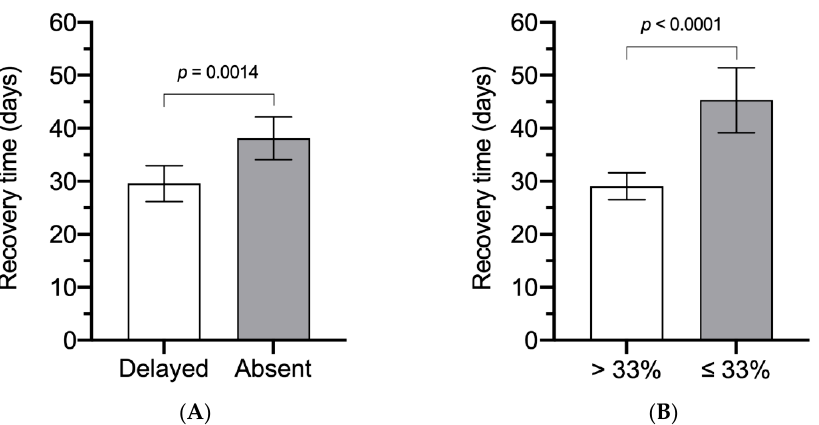
Figure 2. The recovery time classified with different blink reflex (BR) test and facial electroneurography (fENoG) values. ( A ) Different recovery times between patients with a delayed BR and those with an absent BR. ( B ) Different recovery times for those with fENoG values >33% and ≤ 33%. Multivariable regression analysis was performed to evaluate the independent varia- bles associated with the recovery time (Table 3). Age, BR test, and fENoG values were